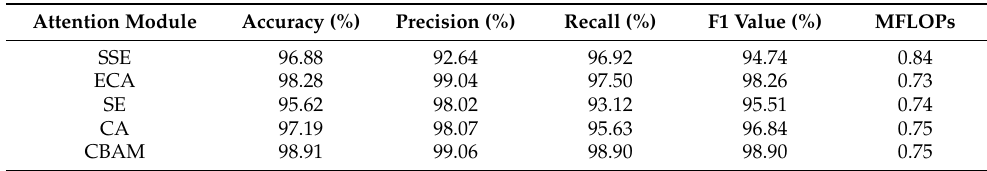
Table 3. Recognition results of attention comparison